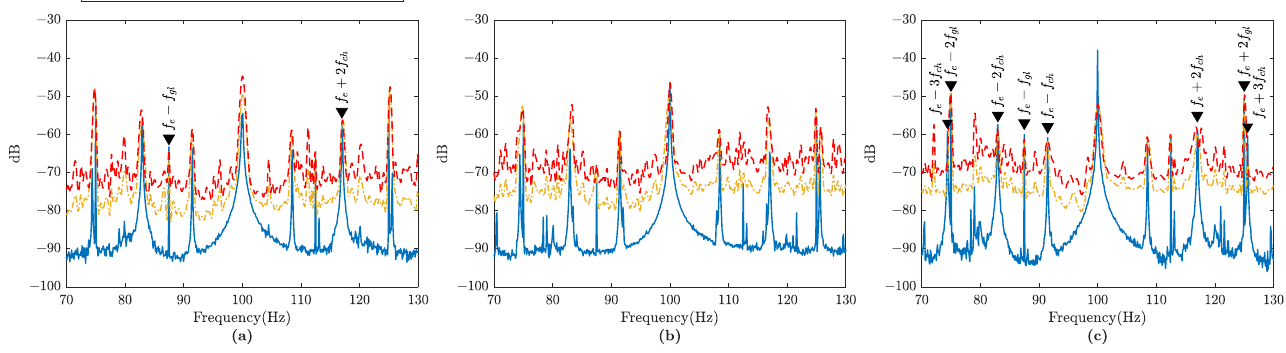
Figure 10. Sprocket–chain fault residual current spectrum: ( a ) chain offset from the driving gear to the driven gear; ( b ) slightly worn damage at a tooth of the driven gear; ( c ) one missing tooth of the driven